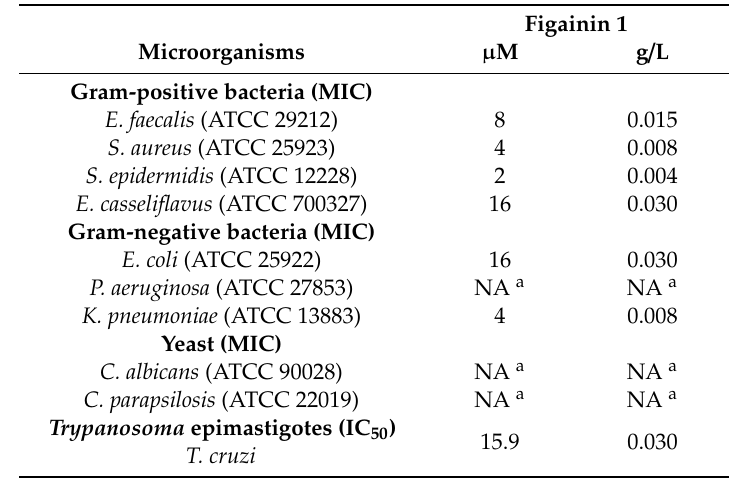
Table 2. Minimal inhibitory concentration (MIC, µM and g/L) for representative pathogenic microorganisms, and half maximal inhibitory concentration (IC 50 , µM and g/L) against epimastigote forms of T. cruzi displayed by Figainin 1.